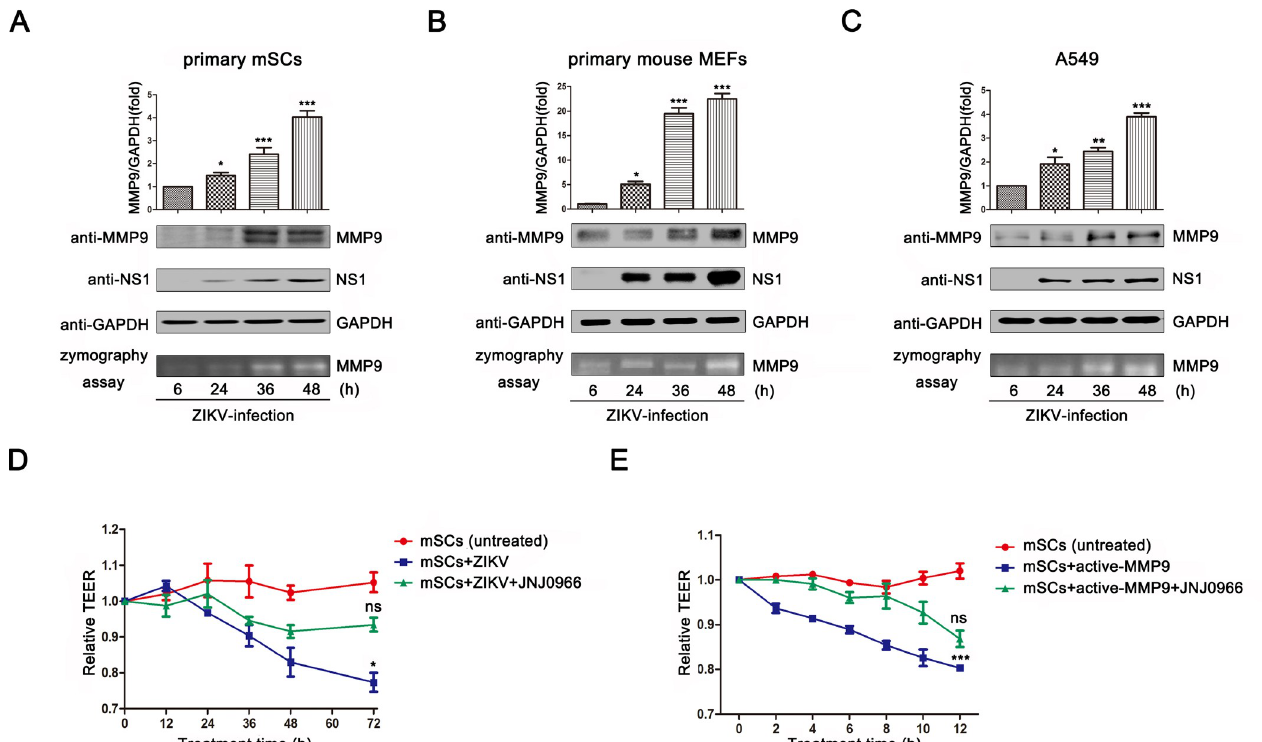
Fig 3. ZIKV infection induced the expression and activity of MMP9 and altered barrier integrity. (A – C) Primary mSCs ( A ), primary MEFs ( B ), and A549 cells ( C ) were infected with ZIKV at a MOI of 1. MMP9 mRNA levels were measured by quantitative RT-PCR (top), MMP9 protein levels were examined by western blotting (middle), and MMP9 proteinase activity was determined by gelatin zymography assays (bottom). Data are expressed as means ± SEMs of three separate experiments. � P < 0.05; �� P < 0.01; ��� P < 0.001. ns, not significant (one-way ANOVA). (D) Primary mSCs were cultured on Transwell semipermeable membranes (0.4 μ m pore size). At day 3, Sertoli cells with an established functional tight junction barrier were infected with ZIKV (MOI = 5) and then treated with or without a specific inhibitor of MMP9 (JNJ0966; 1 μ M). The untreated cells were used as a mock control. The integrity of the SCB model was determined by measuring TEER at each time point. TEER values were expressed in Ohms ( O ). (E) Primary mSCs were cultured on Transwell semipermeable membranes (0.4 μ m pore size), activated MMP9 (50ng/mL) were added and then treated with or without JNJ0966 (1 μ M). The integrity of the SCB model was determined by measuring TEER at each time point. The data are expressed as means ± SEMs of three independent experiments. � P < 0.05; �� P < 0.01; ��� P < 0.001. ns, not significant (one-way ANOVA).